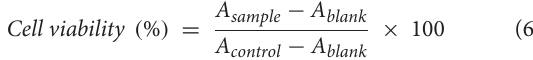
Frontiers in Nutrition |